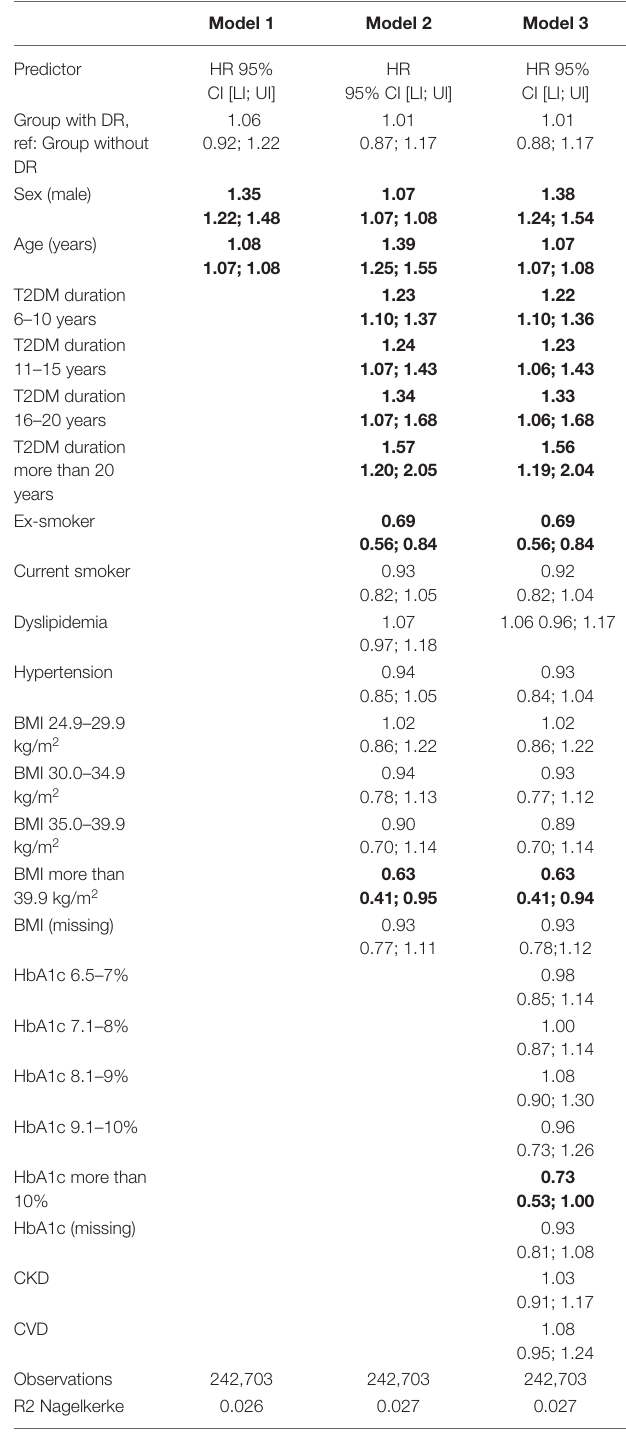
TABLE 4 | Adjusted hazard ratios for different